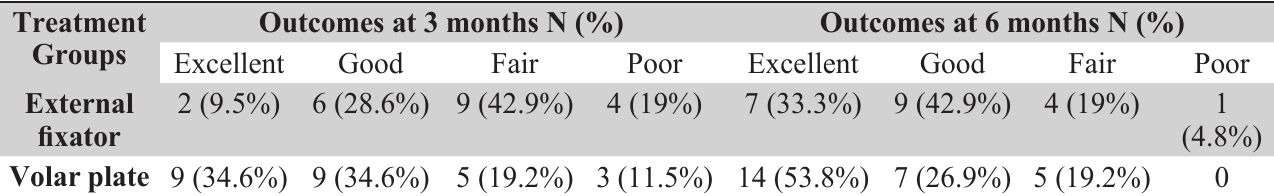
Table 2. Functional outcomes as per the Green and O’Brien scoring at 3 months and 6 months.